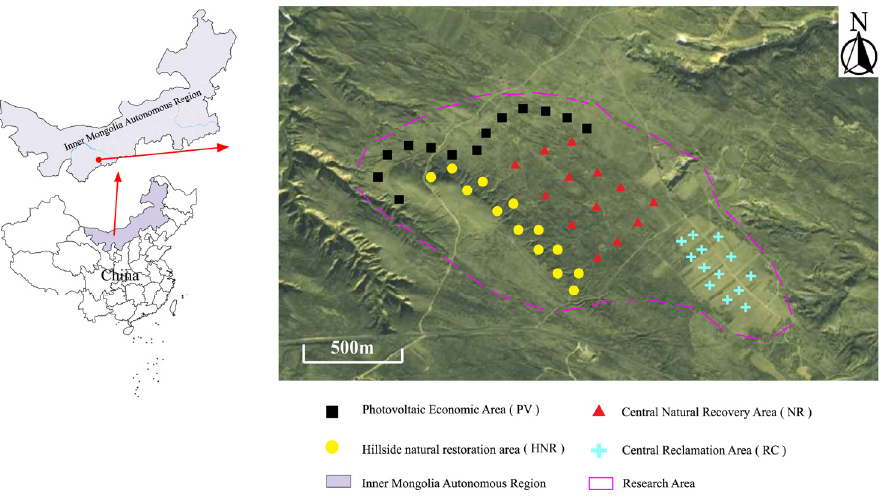
Figure 2. The study area and distribution of sampling sites.